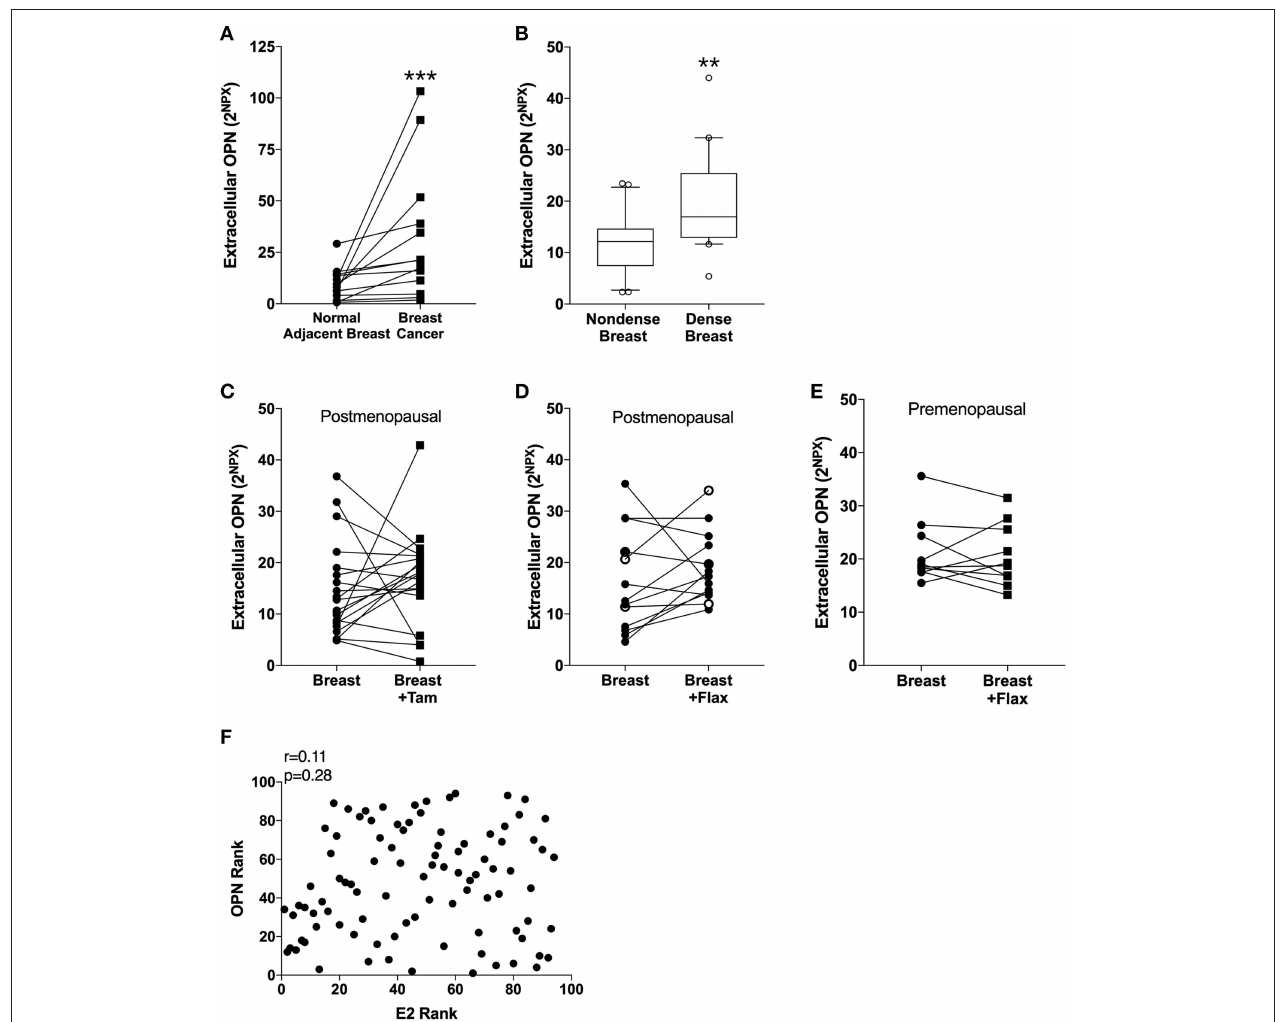
FIGURE 1 | Extracellular levels of Osteopontin (OPN) in breast tissue in vivo. Microdialysis was used to sample in vivo extracellular molecules from breast tissue of women. Proteins were quantified using a multiplex proximity extension assay as described in the materials and methods section. (A) OPN in breast cancer. Thirteen breast cancer patients underwent microdialysis before surgery. One catheter was inserted into the breast cancer and another into adjacent normal breast tissue. (B) OPN in breast tissue of post-menopausal women with various mammographic density. Forty post-menopausal healthy volunteer women, attending the regular mammography-screening program and were categorized as either having dense ( n = 20) or non-dense ( n = 20) breasts underwent microdialysis of their left breast. Boxplots with median and 10–90 percentile are depicted. (C) OPN in normal breast tissue before and after tamoxifen treatment. Nineteen post-menopausal women were investigated in their unaffected normal breast before and after 6 weeks of adjuvant tamoxifen therapy 20 mg/day. (D) OPN in normal breast tissue after flaxseed ingestions in post-menopausal women. Thirteen post-menopausal healthy volunteer women were investigated in their left breast before and after 6 weeks of a diet addition of 25mg ground flaxseed/day. The open symbols represent the two women that did not convert the flaxseed into entereolactone. (E) OPN in normal breast tissue after flaxseed ingestions in premenopausal women. Ten premenopausal healthy volunteer women were investigated in their left breast before and after a diet addition of 25mg ground flaxseed/day for one menstrual cycle. All participants converted flaxseed into entereolactone. In (A–E) ; Wilcoxon matched-pairs signed rank test was used for paired data and Mann-Whitney U -test for unpaired data. ** P < 0.01 and *** P < 0.001. (F) No correlation between OPN in breast tissue and estradiol (E2) levels. Microdialysis was used to sample in vivo extracellular molecules from breast tissue of women. Proteins were quantified using a multiplex proximity extension assay and estradiol with a competitive ELISA as described in the materials and methods section. A total of 94 microdialysis investigations of normal breast tissue unexposed to any treatment is depicted; 42 post-menopausal healthy volunteer women, attending the regular mammography-screening program; 21 post-menopausal women treated for early breast cancer investigated in their unaffected normal breast before the start of adjuvant tamoxifen therapy; 13 post-menopausal healthy volunteer women before the start of dietary flaxseed addition; 10 premenopausal healthy volunteer women before the start of dietary flaxseed addition and four premenopausal women in two consecutive luteal phases of the menstrual cycle. Statistics were calculated using Pearson’s correlations coefficient on ranked